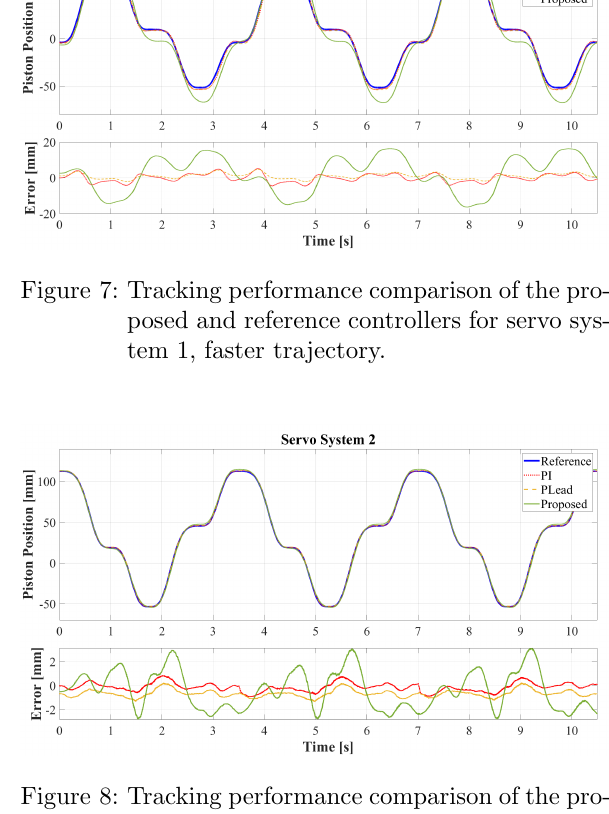
Figure 8: Tracking performance comparison of the pro- posed and reference controllers for servo sys- tem 2, faster